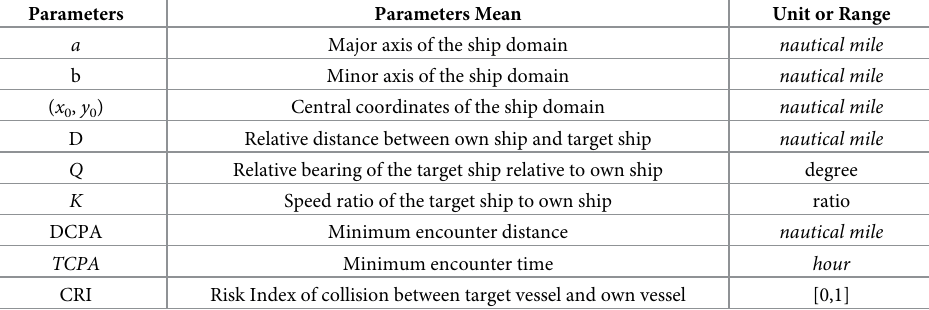
Table 1. The main parameters in this